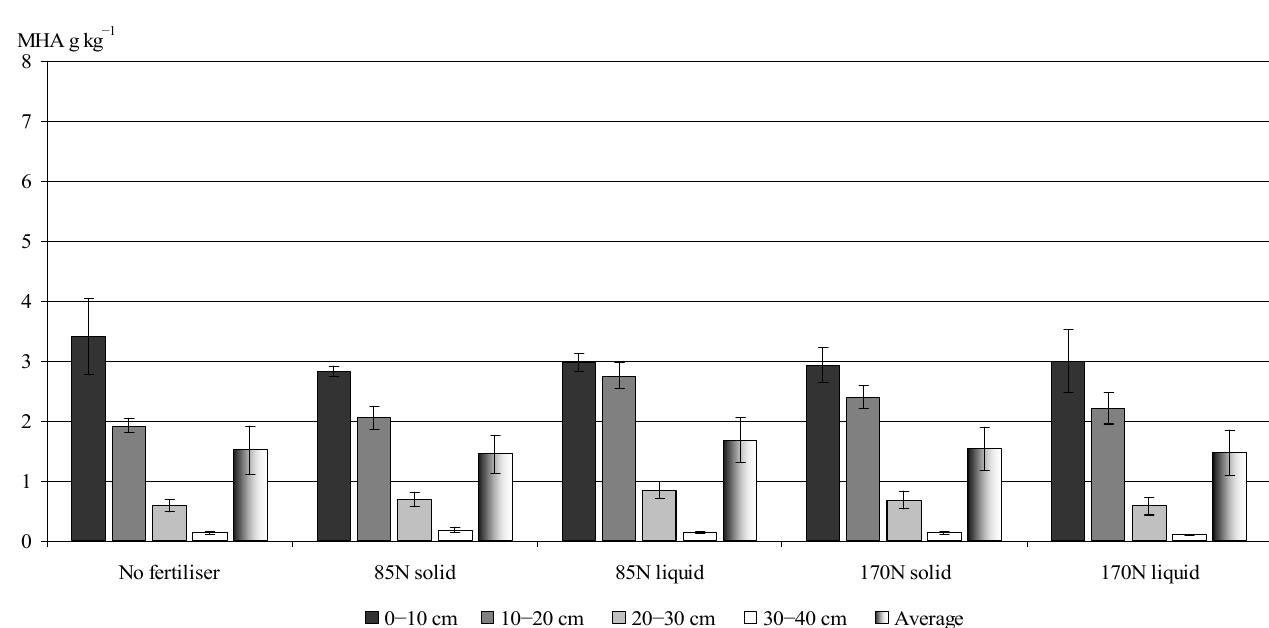
Figure 14. MHS content in the grassland in Fluvisol, 2020 .